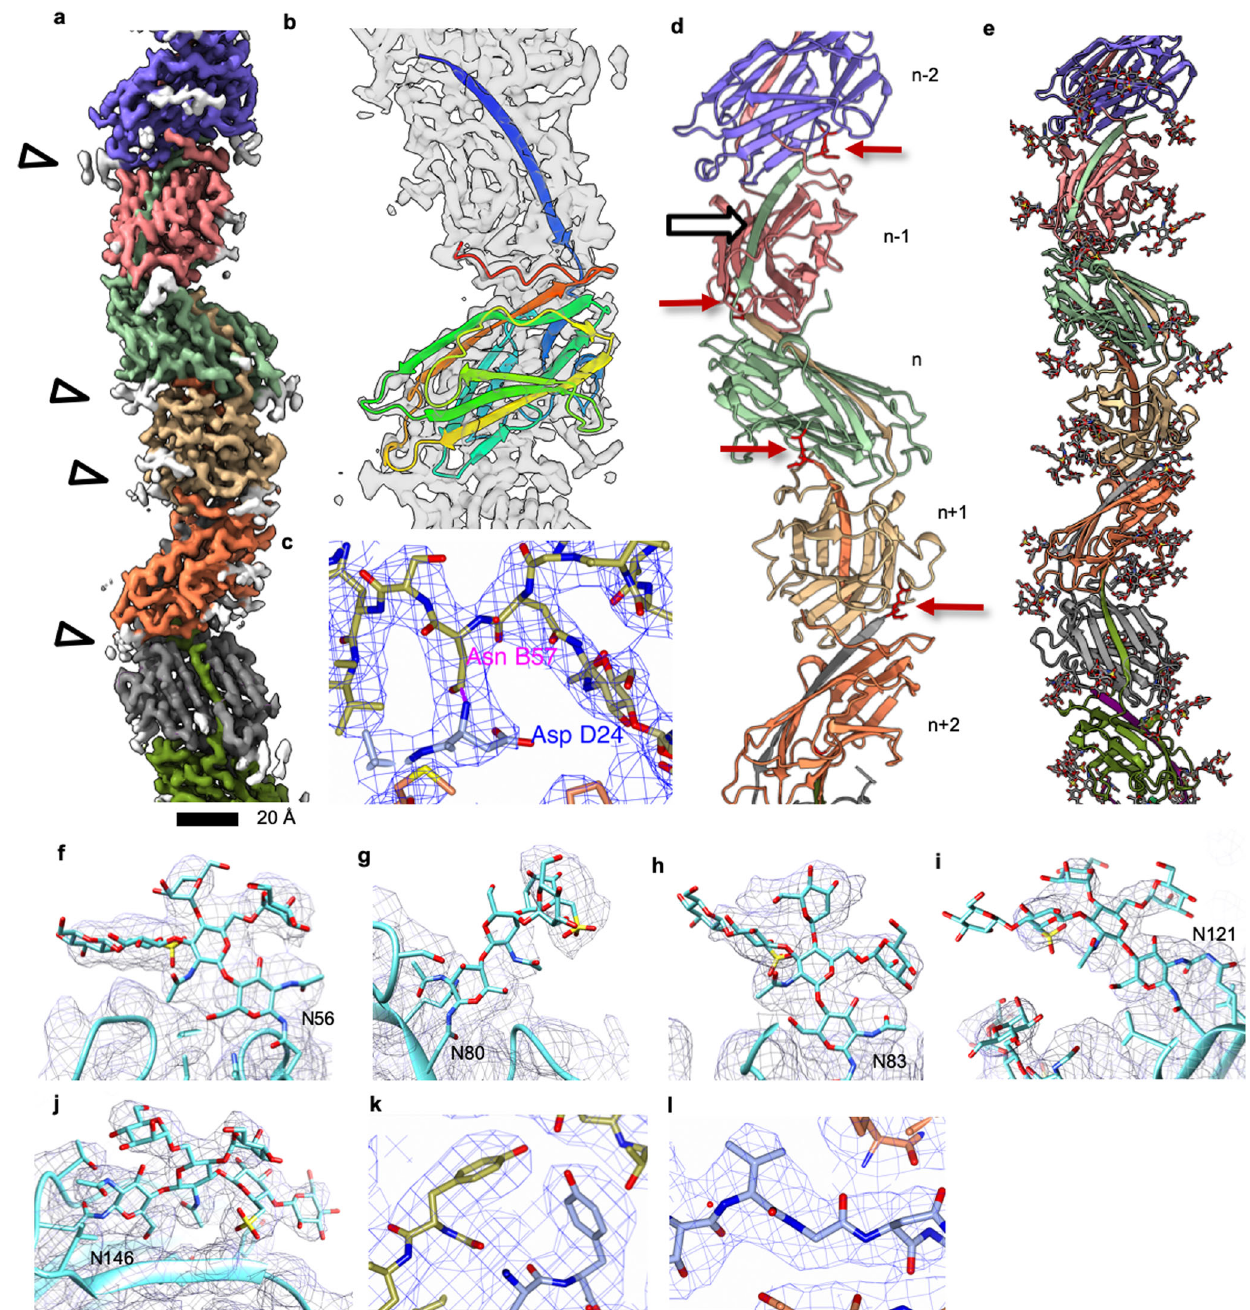
Fig. 1 | Helical reconstruction and atomic model of the thread. a Segmented surface representation of the cryoEM map showing each subunit in a different colour. Glycan densities are shown in white (white arrowheads). b The atomic modelofoneSaci_0406subunit(rainbow) fi ttedintothecryoEMmap(transparent grey) N-terminus, blue; C-terminus, red. Glycans not shown for simplicity. c Intermolecularisopeptide bond is shownasa dashed purple line. The N-terminal residue Asp24 of a subunit ( n +2; carbons in ice blue) appears to be covalently bound toAsn57twosubunits along the chain (n;carbons in gold). d Atomicmodel of 5 consecutive Saci_0406 subunits in ribbon representation. Glycans are not shown for simplicity. A white arrow indicates the location of the donor strand